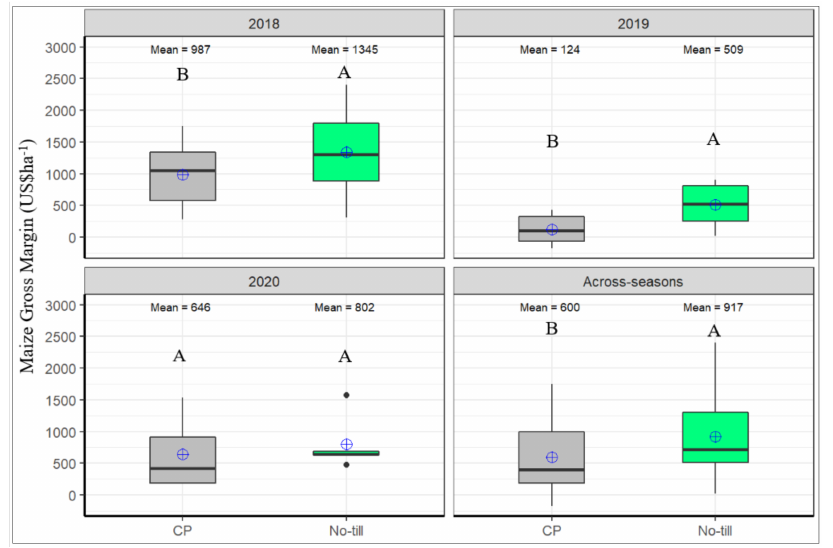
Figure 9. Gross margins from conventional practice and NT treatments under maize cropping system in 2018, 2019, 2020 and across the growing seasons. Means with different letters (A, B) in the same season are significantly different at p <